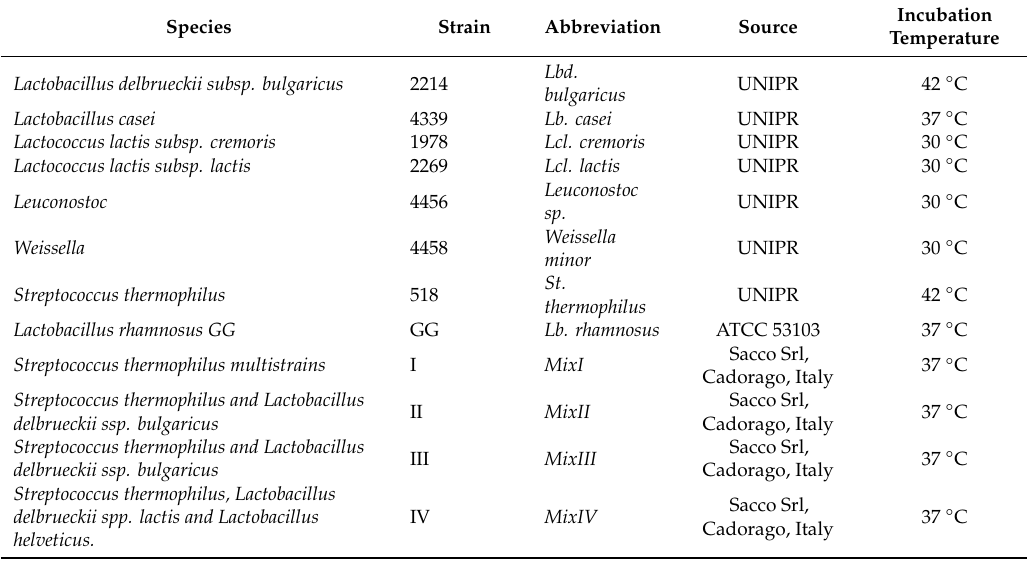
Table 1. Lactic acid bacteria strains (LAB) and commercial mix cultures used in this study.